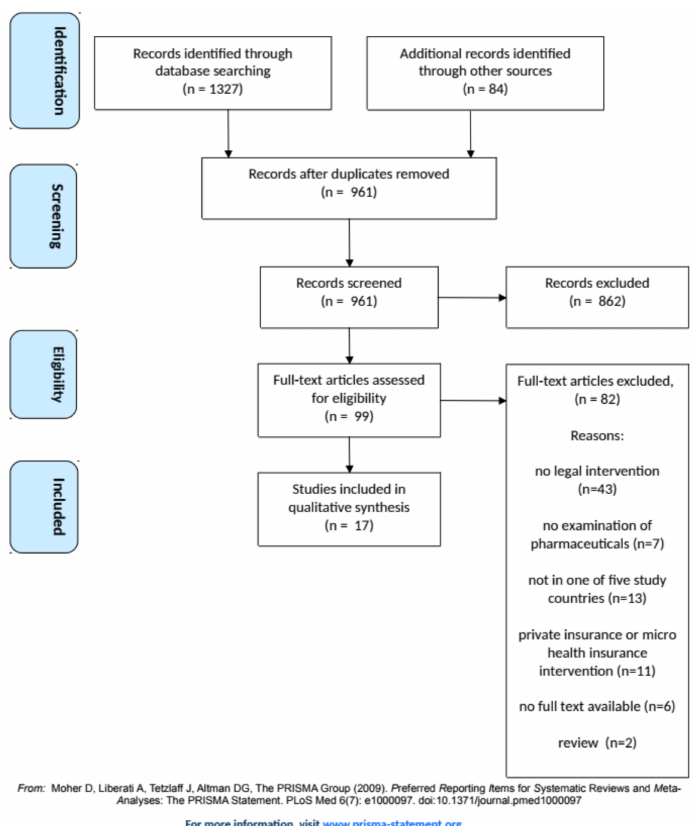
Figure 1. Flow diagram illustrating the selection process of included